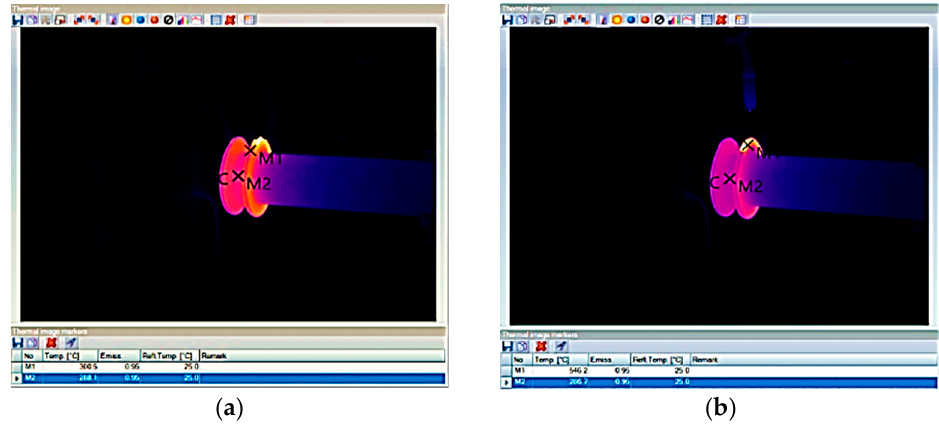
Figure 4. Thermography of the weld seam at the diameter of 170 mm, layer no. 10. Before welding ( a ) and after welding ( b ).